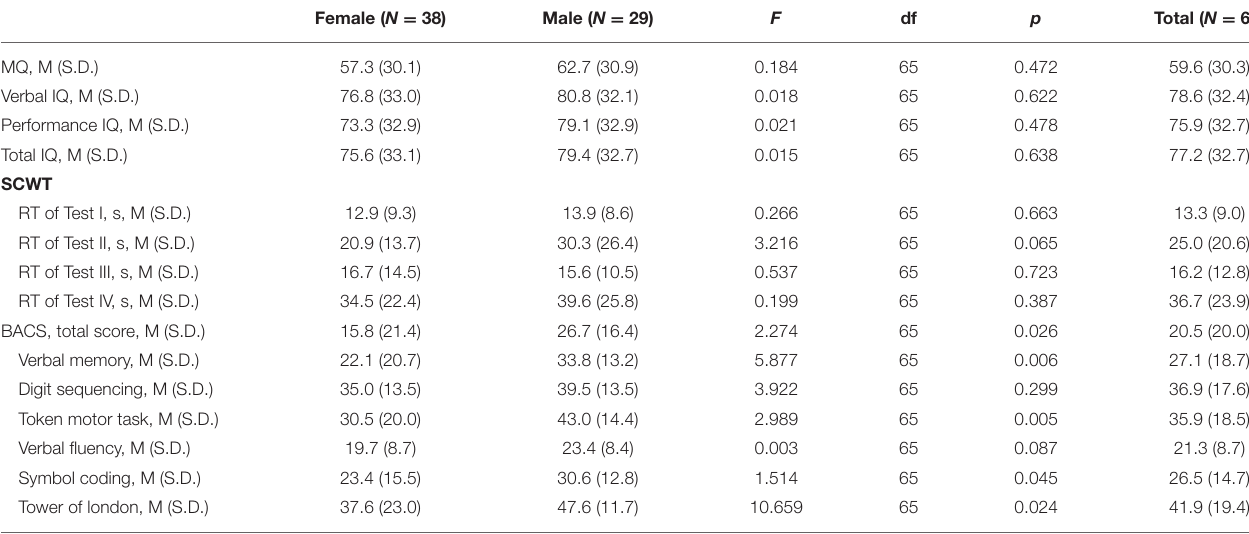
TABLE 4 | Mean baseline metabolic parameters of patients (Chengdu, China, 2018) by sex. Female ( N = 38) Male ( N = 29) F df p Total ( N = 67) UA, mg/dL, M (S.D.) 4.14 (0.82) 3.06 (0.66) 24.912 65 0.000 3.62 (0.92) Hypouricemia, n (%) 0 (0.0) 0 (0.0) 0 (0.0) HC, µ mol/L, M (S.D.) Hyperhomocysteinemia, n (%) 7 (18.4) 0 (0.0) 7 (10.4) TC, mg/dL, M (S.D.) Hypercholesterolemia, n (%) 0 (0.0) 0 (0.0) 0 (0.0) TG, mmol/L, M (S.D.) 0.71 (0.75) Hypertriglyceridemia, n (%) 2 (5.3) 5 (7.5) PRL, ng/mL, M (S.D.) Hyperprolactinemia, n